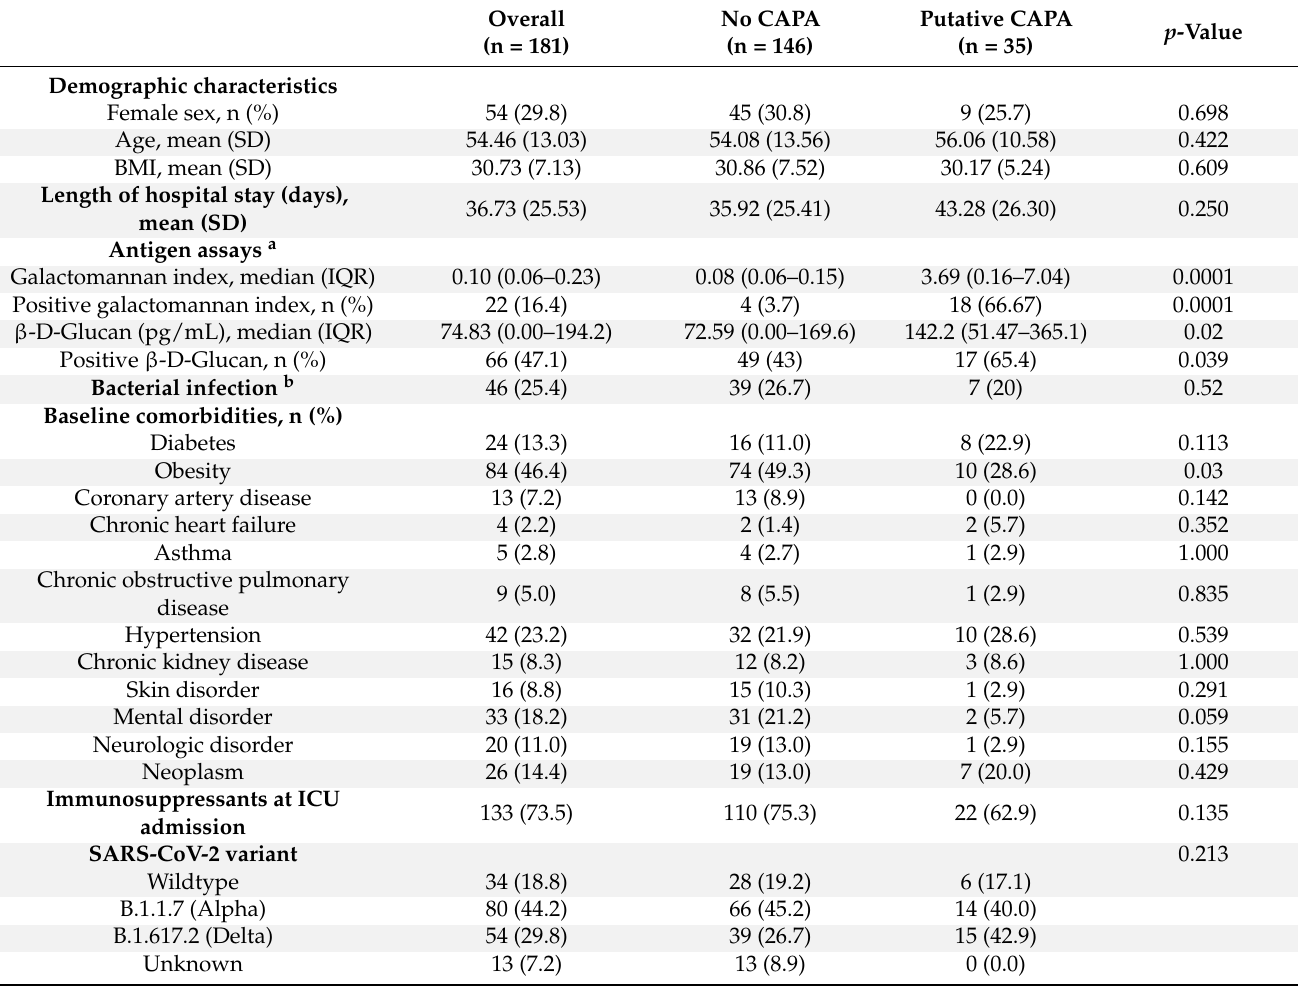
Table 1. Baseline characteristics of the study